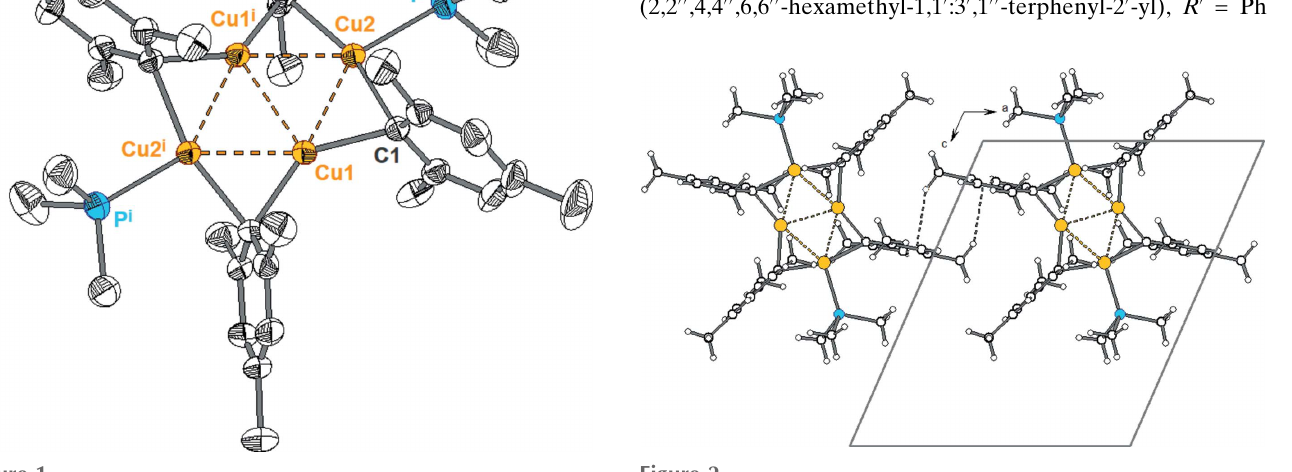
Figure 1 Molecular structure of [Cu 4 Mes 4 (PMe 3 ) 4 ] showing the labeling scheme. Displacement ellipsoids were drawn at the 50% probability level, H atoms are omitted for clarity. [Symmetry code: (i) (cid:5) x + 1, y , (cid:5) z + 1